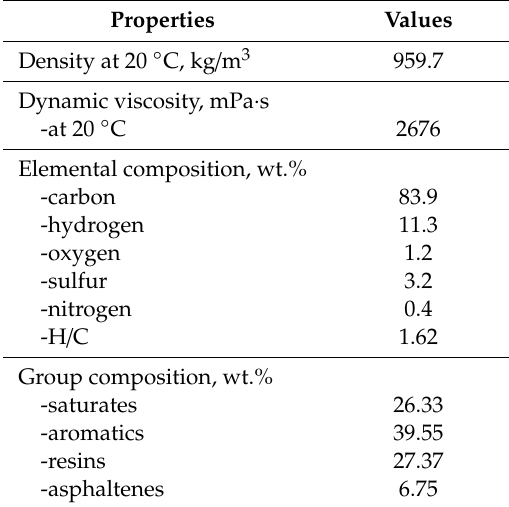
Table 3. Physical and chemical properties of initial Ashal’cha heavy